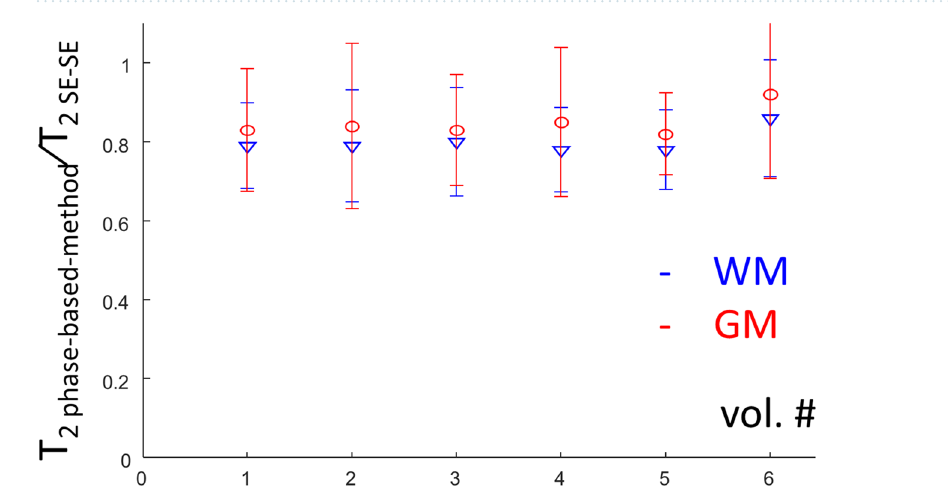
Figure 6. Comparison of T 2 estimation between the phase-based method and SE–SE. The plot shows the ratio T 2 phase-based-method /T 2 SE–SE per volunteer, both for WM and for GM. The error bars depict the relative deviation error [see Eq.